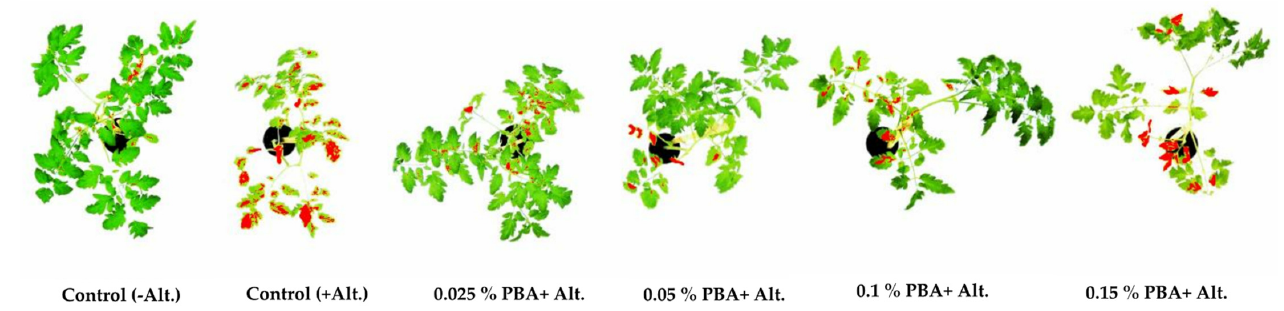
Table 7. Effect of tomato plants pretreatment with PBA on the severity of early blight symptoms, caused by Alternaria alternata 14 days post ‐ inoculation.